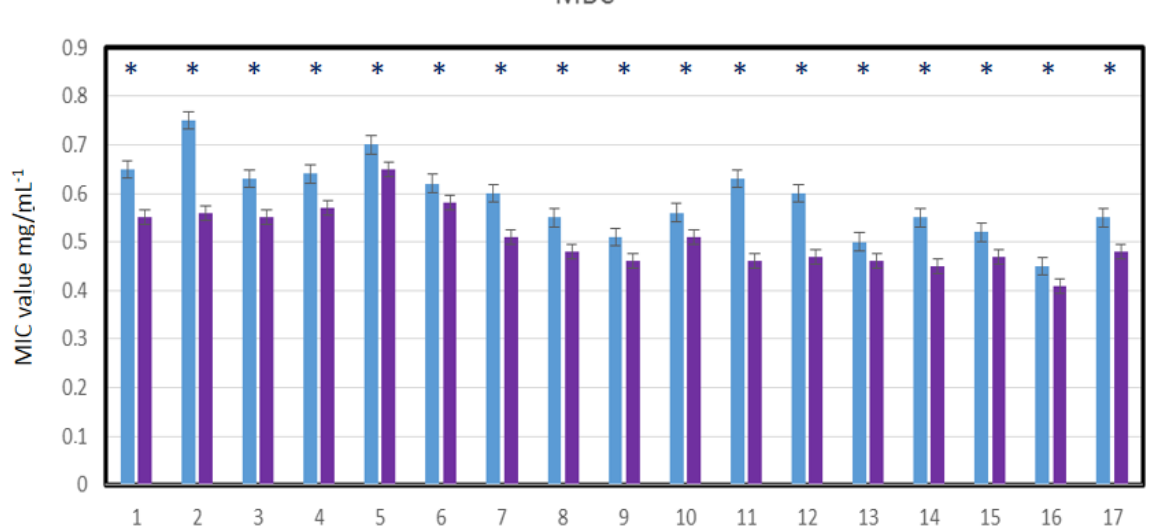
Figure 12. Virus particle analysis using MBC test (panel A- infected volunteers without SARS-CoV-2) and (panel B- infected volunteers after treatment of Salistat SGL03). Statistical significance vs. control in all analyzed samples were at * p < 0.05. X-axis number of study participants from 1 to 17.